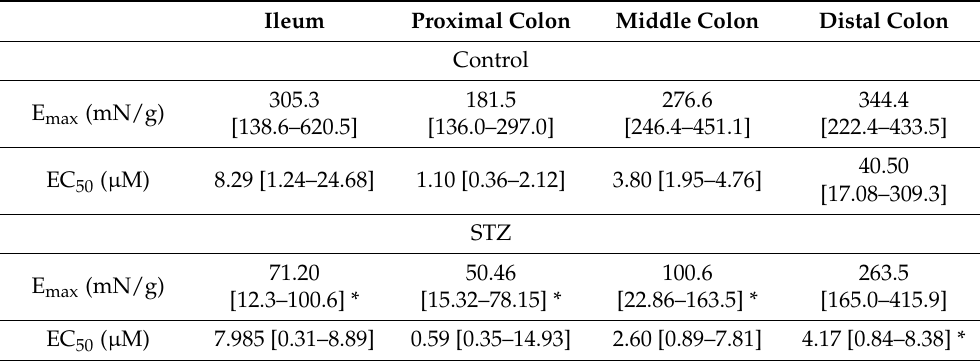
Table 2. E max (mN/g) and EC 50 ( µ M) values of smooth muscle contraction induced by Angiotensin II application in the ileum, proximal colon, middle colon, and distal colon of control (CTRL, n = 5–8) and streptozotocin-induced diabetic rats (STZ, n = 5).